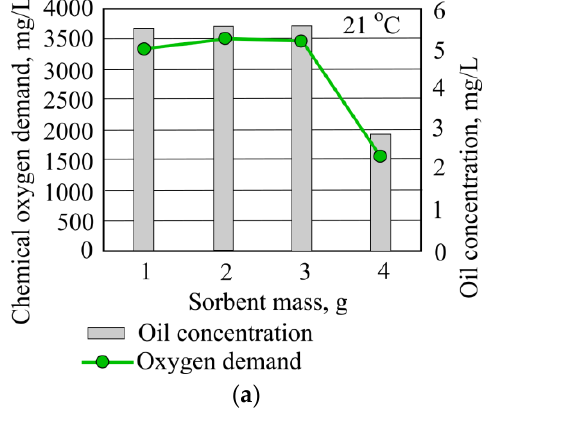
Figure 16. Chemical oxygen demand and oil concentration when investigated water is at ( a ) 21 °C and ( b ) 70 °C using hydrophobic peat sorbent.